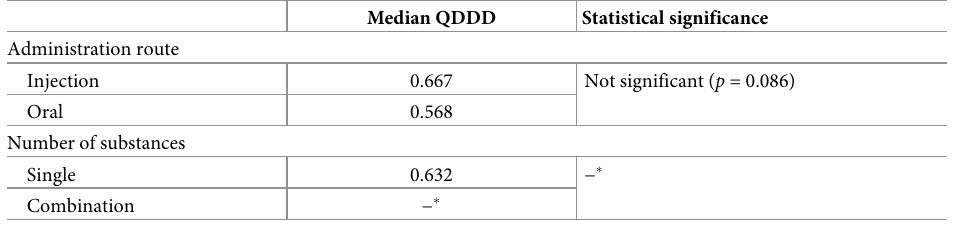
DDD defined daily doses Median QDDD calculated quotient of Japanese daily doses and the corresponding values of the European Medicines Agency � Statistical evaluation was not possible because there was no combination antimicrobial agent for which DDDvet and DDDjp values were available